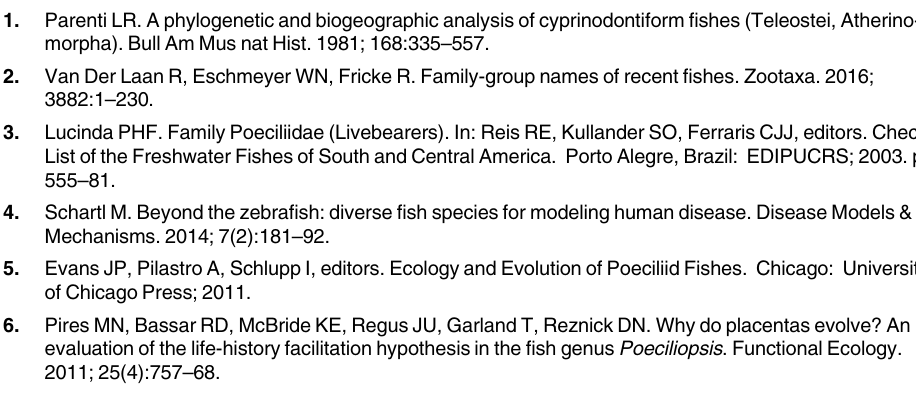
S2 Table. Area assignments. S3 Table. Details of colonization events summarized in Table